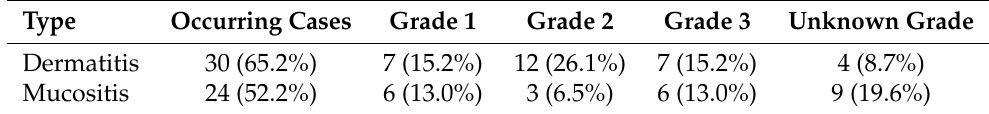
Table 3. Acute side effects of radiotherapy, classified by type and grade.